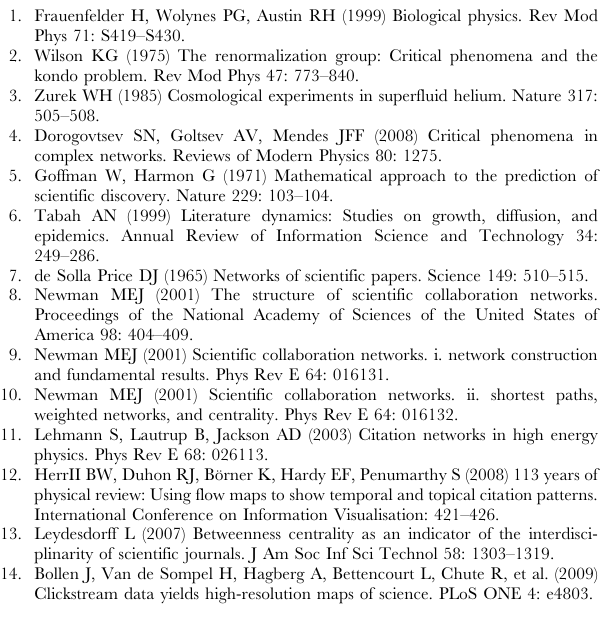
Figure S7 The ratio r of the size of the largest community present divided by size of the second largest community for every time bin for l= 2.5. Large r indicates the presence of overly large communities that obscure the community structure; thus k = 8 is an unfavorable choice of parameter. Figure S8 Size of the nuclear physics community vs time for k = 9 and k = 10, using l =2.5. While the community appears to die at t =8 (4 years) for k =9, a community of similar nodes is seen to continue beyond the time of apparent death when using the higher community cohesiveness requirement of k = 10. It is possible then that the nuclear physics community is still present in the analysis, but has merged with another community. Figure S9 Merger of the nuclear physics community (green) with another community (particle physics: specific reactions